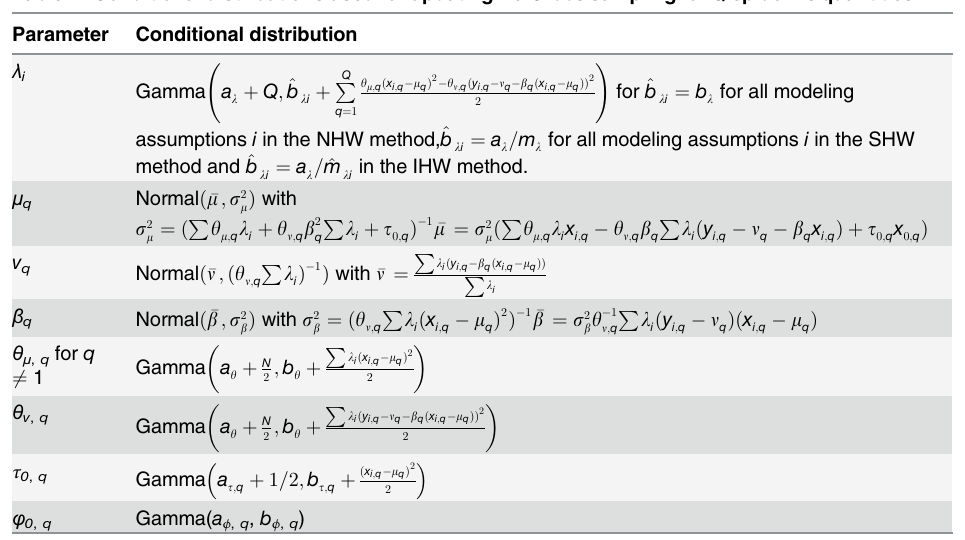
Table 4. Conditional distributions used for updating via Gibbs sampling for Q epidemic